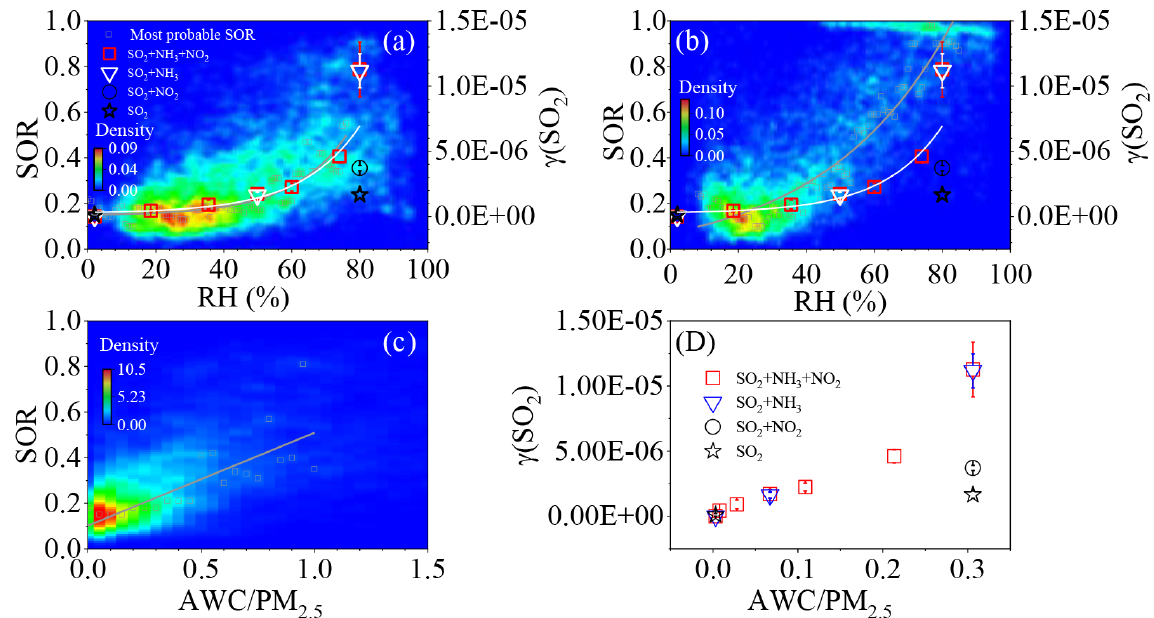
Figure 3. Relationship between SOR and γ SO on dust internally mixed with NH 4 NO 3 (2 : 1) and RH in (a) Shijiazhuang and (b) 2 , BET Beijing and the correlation of (c) SOR in Shijiazhuang and (d) γ SO with AWC / PM 2 . 5 . The initial concentrations of SO 2 , NO 2 and/or 2 , BET NH 3 in the flow tube reactor were 190 ± 2.5, 100 ± 2.5 and/or 50 ± 2.5ppb, respectively. The grey lines are the fitting curves for the most probable SOR, and the white lines are the fitting curves for the γ SO 2 , BET